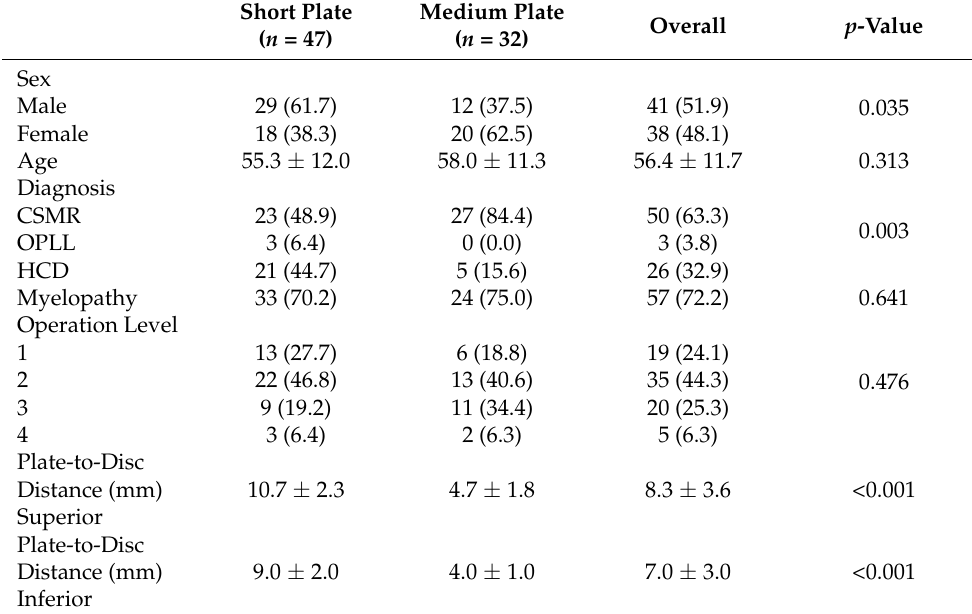
Table 1. Comparison of demographic characteristics between the 2